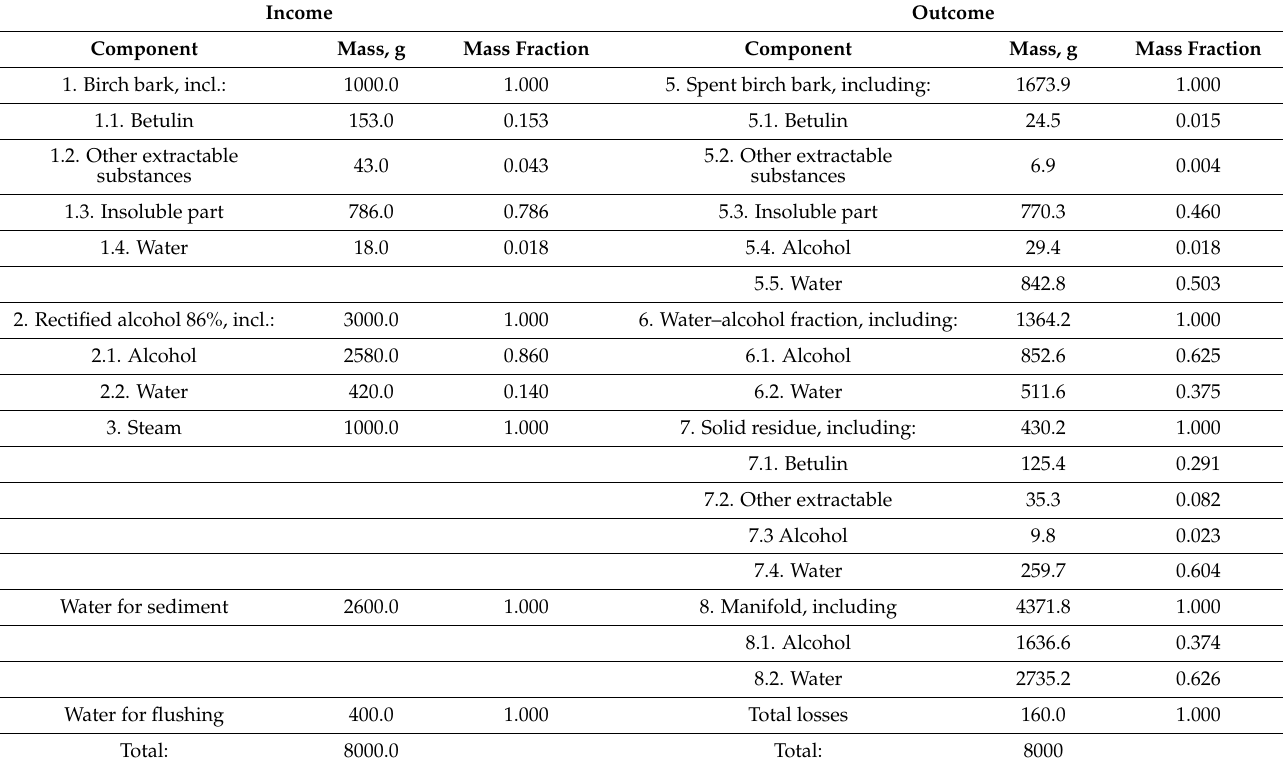
Table 5. Material balance of the birch bark extraction and stripping